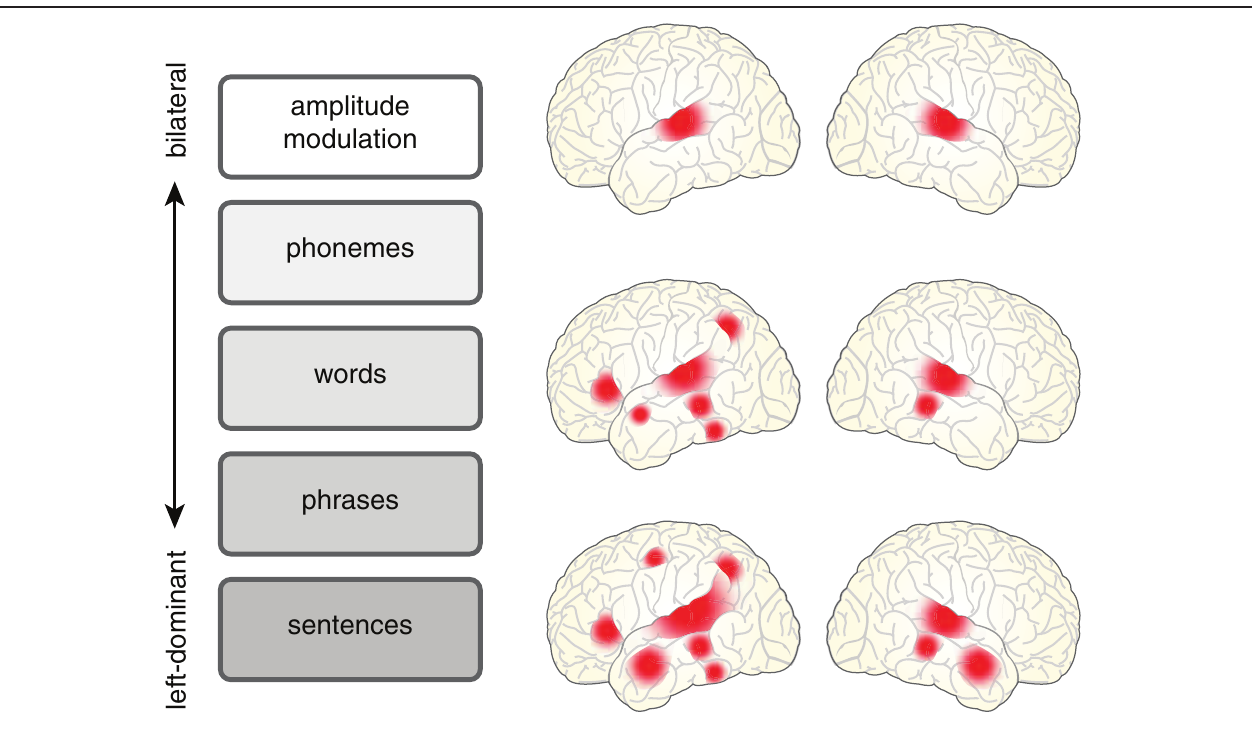
requirements for linguistic analysis and integration increase, neural processing shows a concomitant increase in its reliance on left hemisphere regions for words [see meta-analysis in Davis and Gaskell (2009)] and sentences [see meta-analysis in Adank